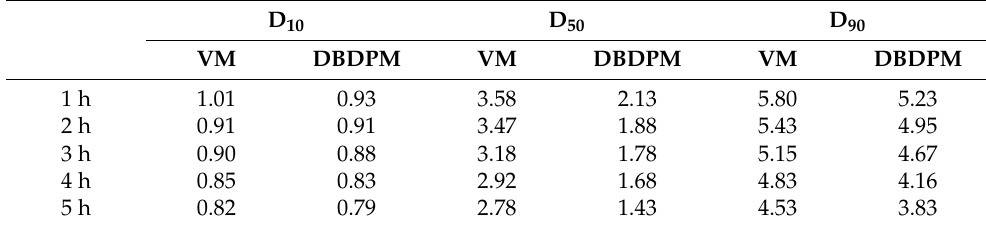
Table 4. Particle size of alumina powder after different milling times ( µ